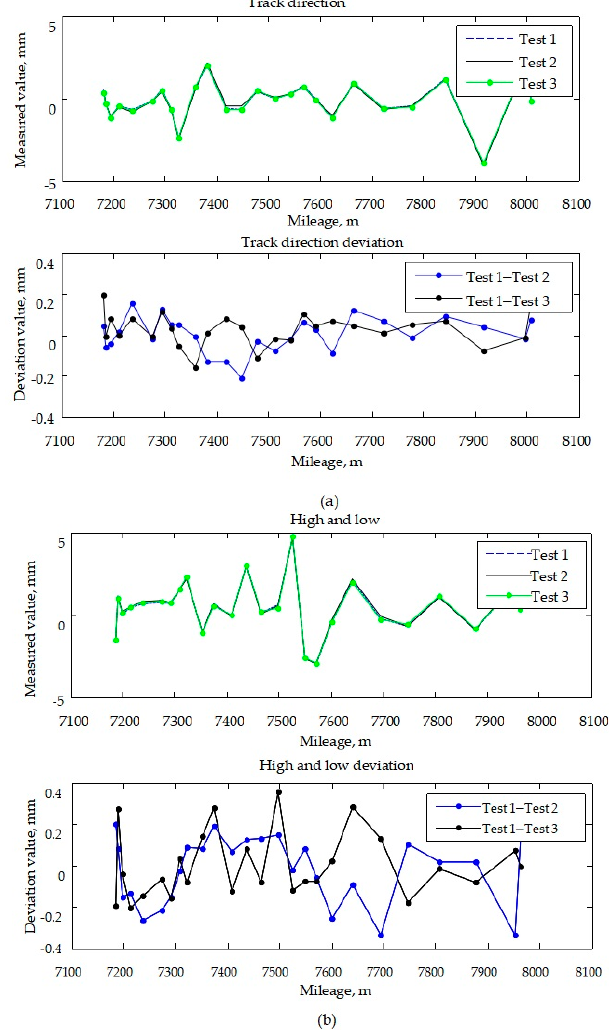
Figure 7. Cont. Figure 7.